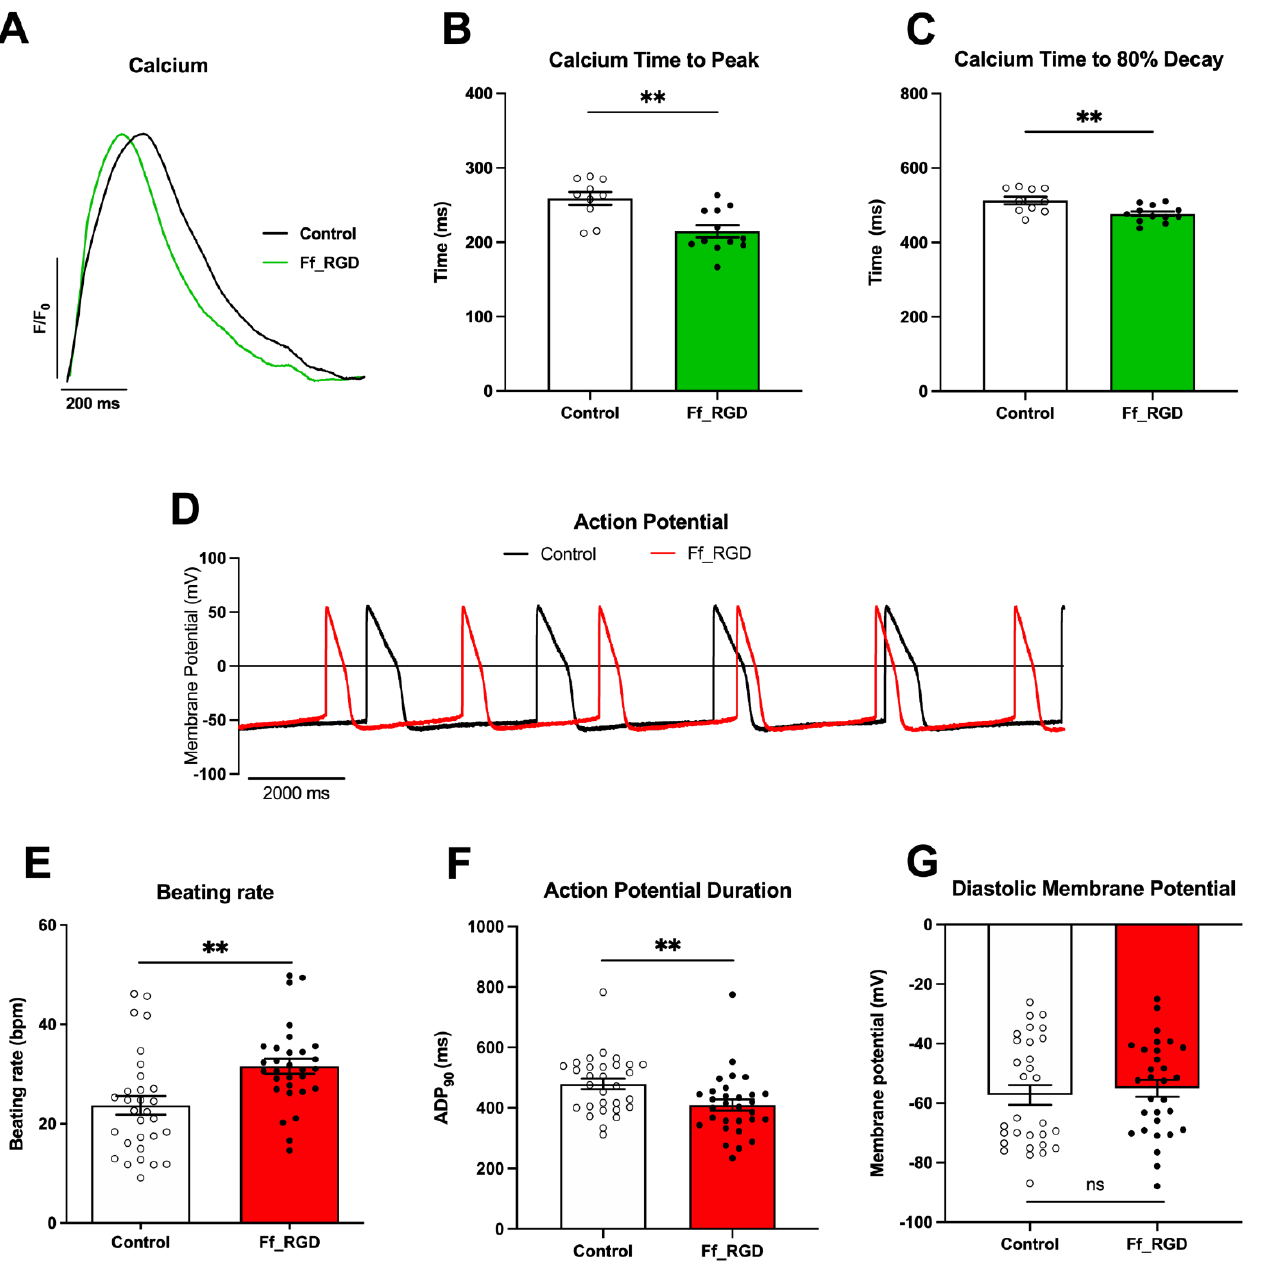
Figure 1. Fibril − forming integrin ligands module cardiomyocyte Ca 2+ transients and action potential morphology. ( A ) Ca 2+ transient representative traces after 24 h treatment with ff_RGD (2 mM) (green) compared to control (black) during 1 Hz field − stimulation. Ca 2+ transient ( B ) TTP (** p = 0.0016) and ( C ) T80 illustrated as means ± SEM (** p = 0.0055) ( n = 10 control, n = 12 ff_RGD images from four batches). ( D ) AP representative traces of spontaneously beating ff_RGD − treated cardiomyocytes (red) compared to control (black). Parameters measured were ( E ) beating rate (** p = 0.0018), ( F ) AP duration (** p = 0.0029), and ( G ) maximum diastolic membrane potential (ns p = 0.602) illustrated as means ± SEM ( n = 30 control, n = 30 ff_RGD cells from 10 dishes, duplicates from five batches). hiPSC − CMs were used at day 40 – 46 of differentiation.